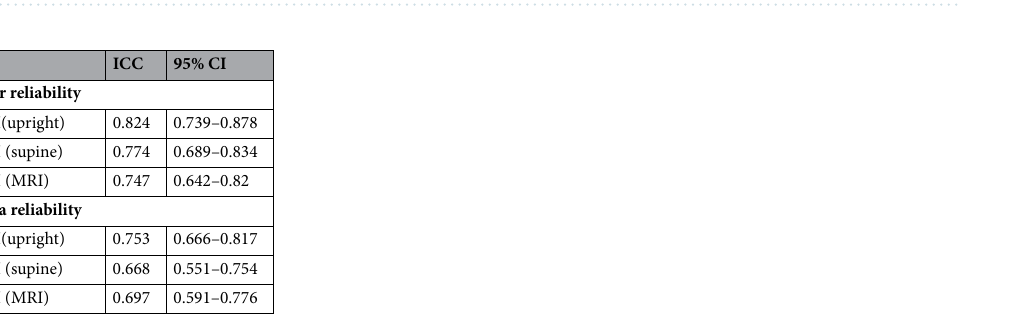
Table 4. Summarizes the inter/ intra observer reliability, AHI = acromiohumeral interval, CI = confidence